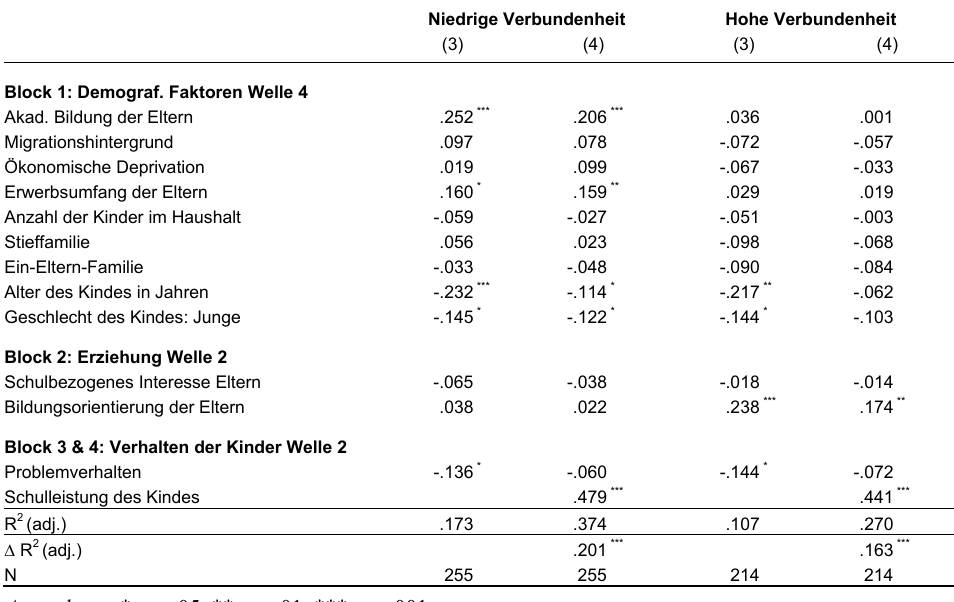
Tabelle 3 : Effekte auf Schulleistung Welle 4 in Abhängigkeit von der